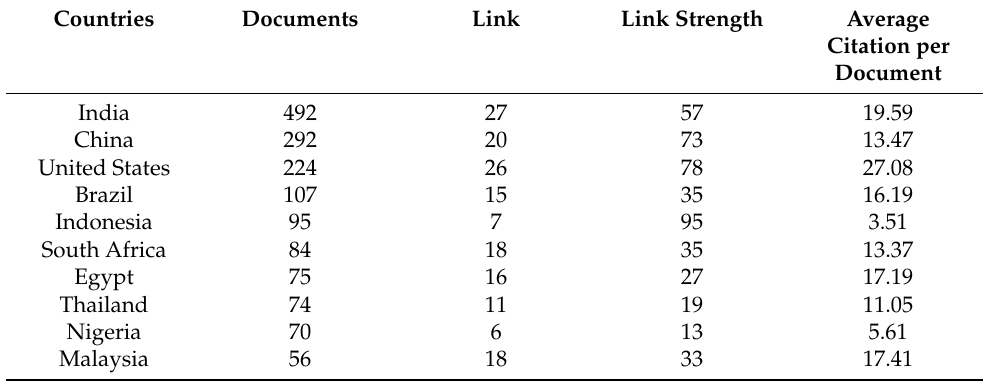
Figure 4. Co-authorship relations among countries, with an average publication year as the color gradient. Table 3. Top 10 countries by document volume.